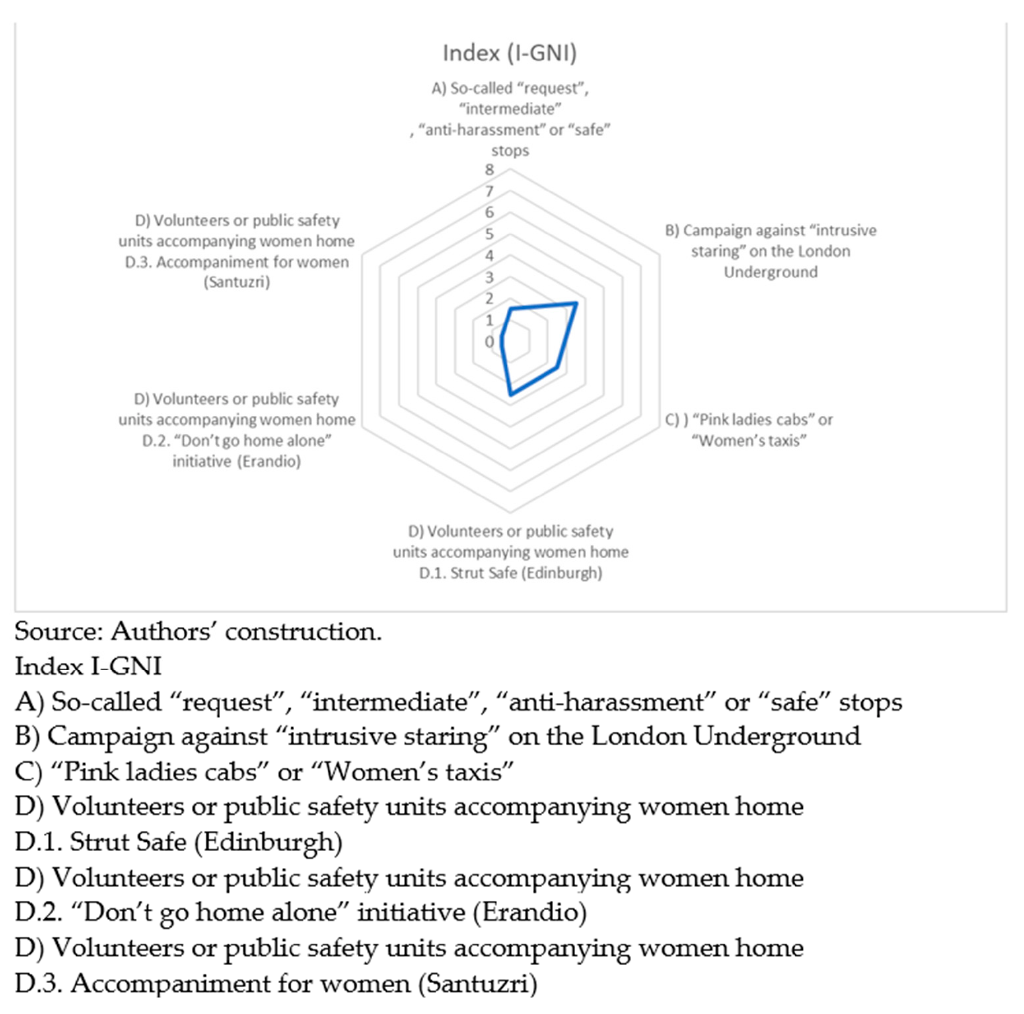
Figure 1. Application of I-GNI to initiatives against sexual violence in sexual space. Index from 0 (need) to 8 (interest).